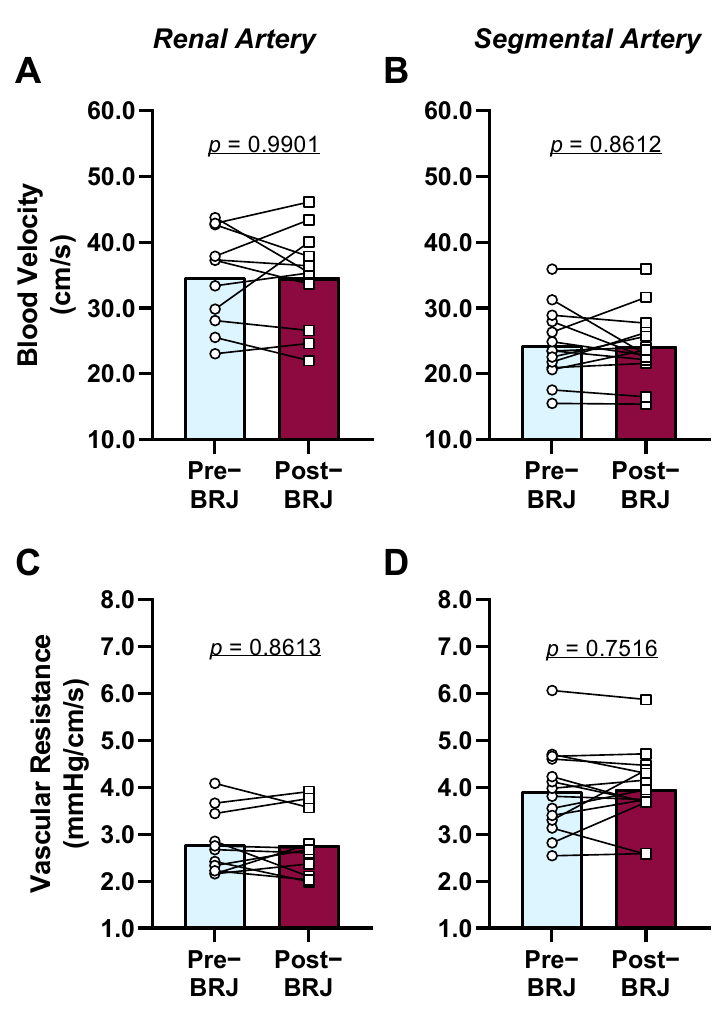
Figure 1. Effect of beetroot juice (BRJ) at three hours post-consumption on renal (panels A and C , n = 11, 5 females and 6 males) and segmental (panels B and D , n = 14, 7 females and 7 males) artery blood velocity and vascular resistance during room air breathing. Data were analyzed using a two-tailed paired t -test and are presented as the means (bar) with individual values.